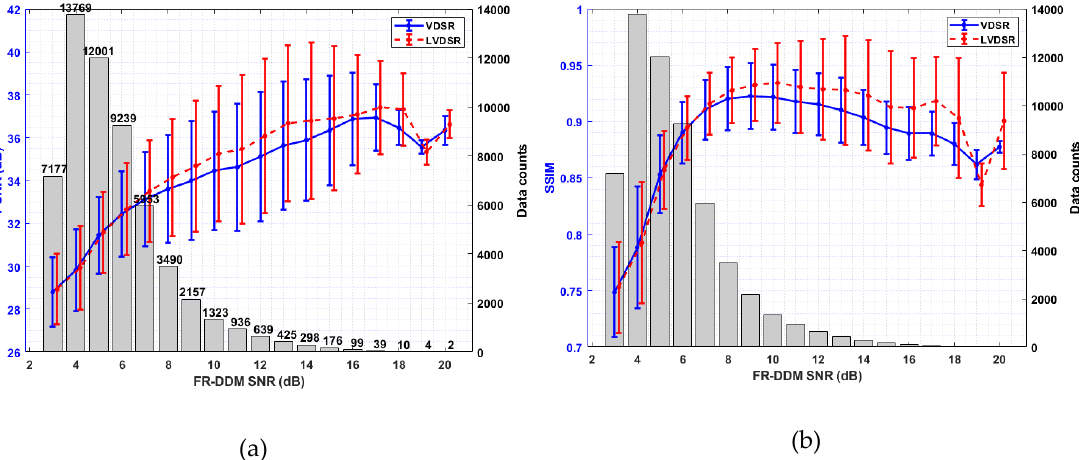
Figure 12. Quality of DDM reconstruction for different FR-DDM SNR. ( a ) PSNR value versus FR-DDM SNR for VDSR (blue) and LVDSR (red), along with the data histogram in the background (right vertical axis). ( b ) SSIM value versus FR-DDM SNR for VDSR (blue) and LVDSR (red), along with the data histogram in the background (right vertical axis).